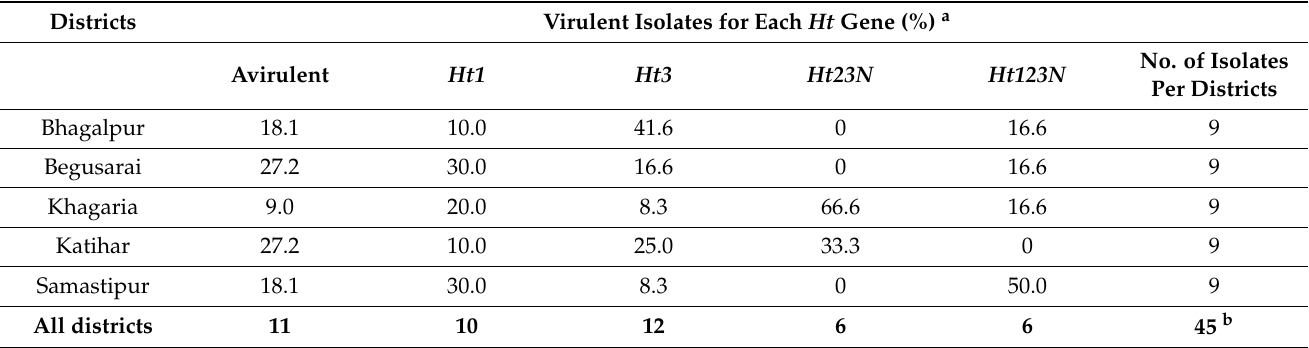
Table 4. Frequency of E. turcicum isolates virulent to the Ht resistance genes within and across